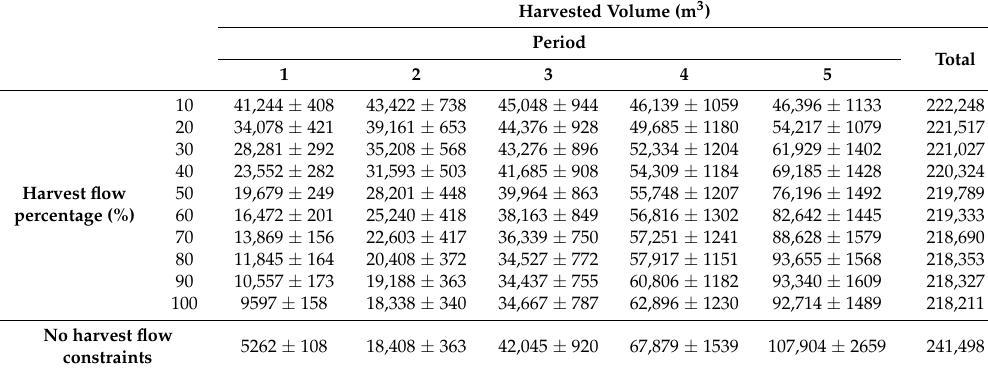
Table 2. The average periodic and total harvested volumes and their standard deviations for different harvest flow percentages obtained by simulation experiments for the DET model´s results for 50% protection level in the first